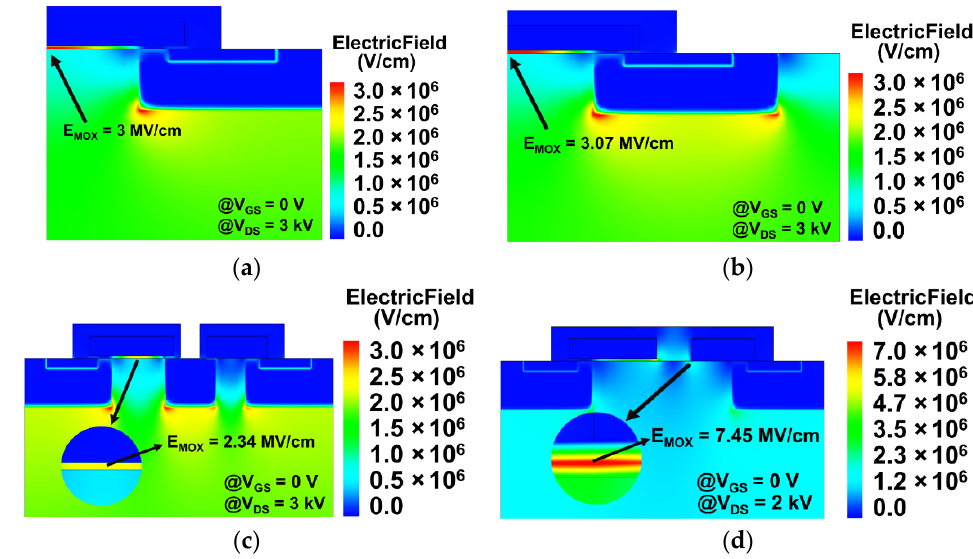
Figure 4. Electric field distribution of ( a ) C – DMOSFET, ( b ) SBD – MOSFET, ( c ) CIMCD – MOSFET, and ( d ) MCD – MOSFET without the center implant region.